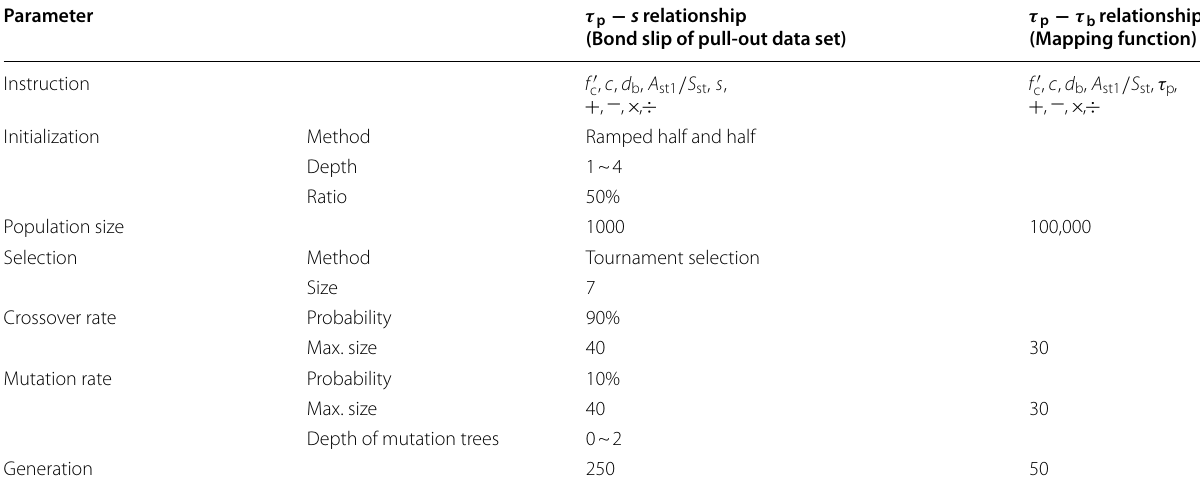
Table 6 Evolutionary parameters.